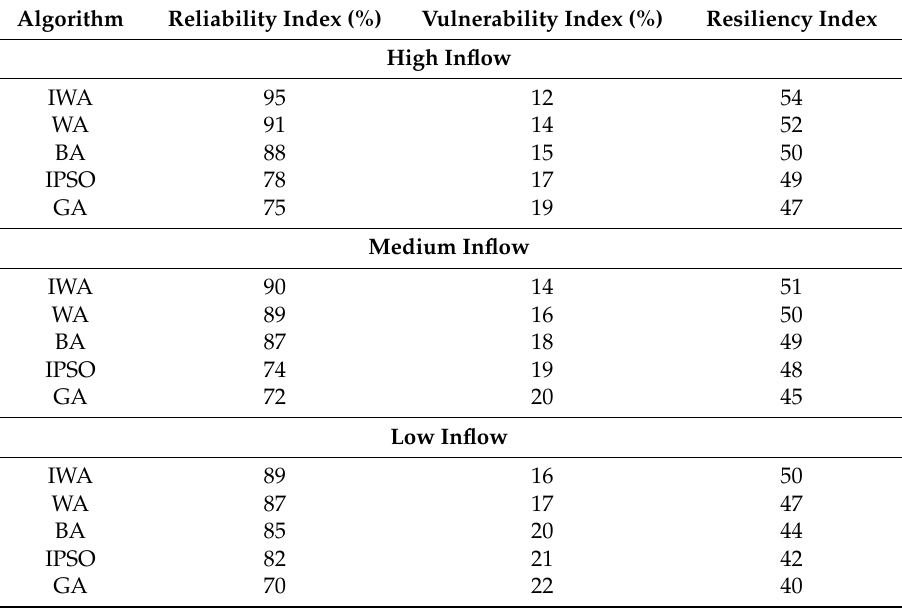
Table 10. Computed different indexes for different